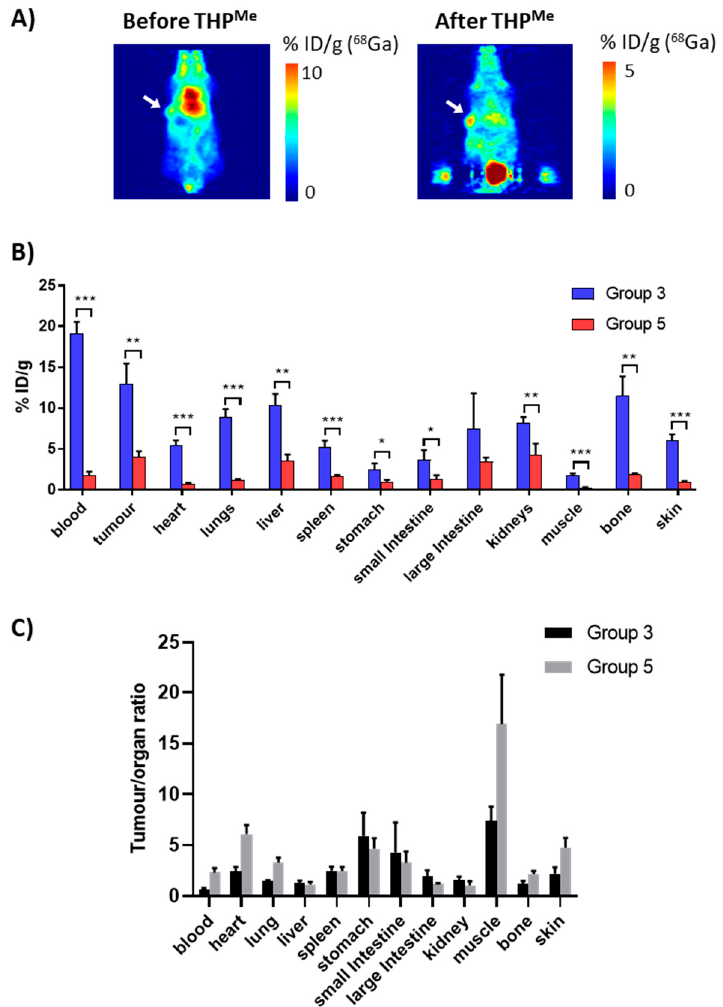
Figure 6. Investigation on the use of THP Me as a 68 Ga blood clearance agent. The upper panels ( A ) show example PET images (coronal view, thickness 0.87 mm) illustrating the biodistribution of 68 Ga in a nude mouse bearing SW1222 xenografts before (( left ), 40 min after 68 Ga administration) and after (( right ), 80 min after 68 Ga administration) the injection of THP Me as a blood clearance agent at 1 h after 68 Ga administration. Note that the colour scales for the “before” and “after” images are different. Hot spots visible outside the mouse body in the coronal projection ( A, right panel ) are image artefacts due to the extremely high proportion of the activity in the bladder. White arrows indicate location of the tumour. Voxel size is 0.87 × 0.87 × 0.80 mm 3 . The middle panel ( B ) shows ex vivo 68 Ga biodistribution at 3 h after 68 Ga injections in nude mice bearing SW1222 xenografts, comparing mice treated with THP Me at 1 h post 68 Ga injections and the control group. For each group n = 5. Data are presented as mean ± SD. Comparison between the two groups was performed by a two-tailed t -test for each organ. * = p < 0.05, ** = p < 0.0001, *** = p < 10 − 5 . The lower panel ( C ) compares tumour-to-organ ratios of %ID/g for treated and untreated mice, showing that treatment with THP Me increases tumour-to-blood and other tumour-to-background ratios that are likely to affect tumour detection.